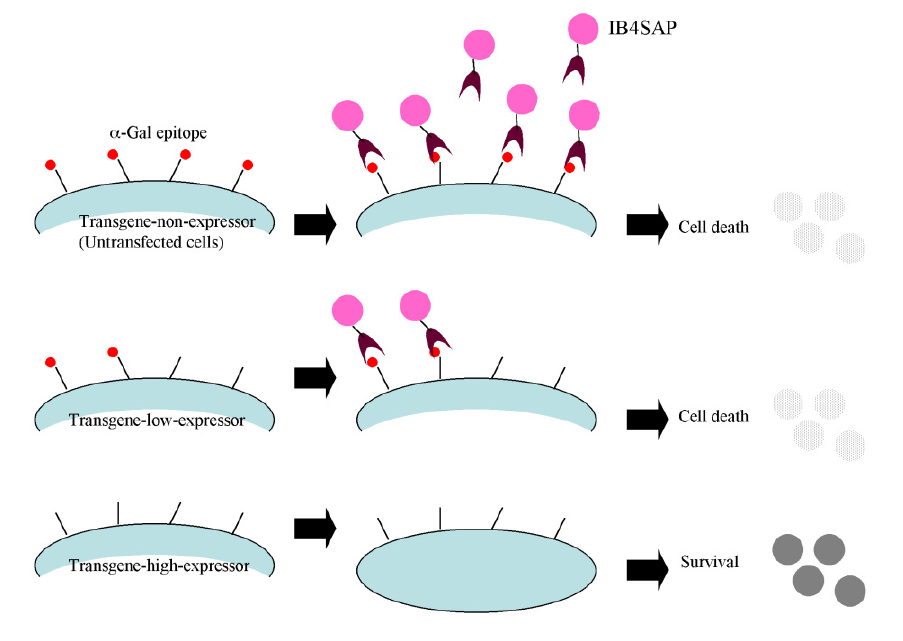
Figure 1. Schematic diagram of a mechanism for targeted toxin-mediated drug-free (cid:76)(cid:86)(cid:82)(cid:79)(cid:68)(cid:87)(cid:76)(cid:82)(cid:81)(cid:3) (cid:82)(cid:73)(cid:3) (cid:70)(cid:72)(cid:79)(cid:79)(cid:86)(cid:3) (cid:90)(cid:76)(cid:87)(cid:75)(cid:3) (cid:75)(cid:76)(cid:74)(cid:75)(cid:3) (cid:87)(cid:85)(cid:68)(cid:81)(cid:86)(cid:74)(cid:72)(cid:81)(cid:72)(cid:3) (cid:72)(cid:91)(cid:83)(cid:85)(cid:72)(cid:86)(cid:86)(cid:76)(cid:82)(cid:81)(cid:17)(cid:3) (cid:55)(cid:75)(cid:72)(cid:3) (cid:88)(cid:81)(cid:87)(cid:85)(cid:68)(cid:81)(cid:86)(cid:73)(cid:72)(cid:70)(cid:87)(cid:72)(cid:71)(cid:3) (cid:70)(cid:72)(cid:79)(cid:79)(cid:86)(cid:3)